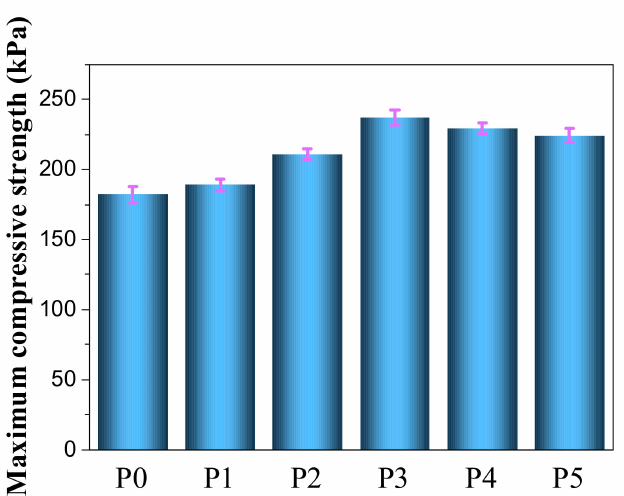
Figure 5. Maximum compressive strength of RPUF and its flame-retardant RPUF